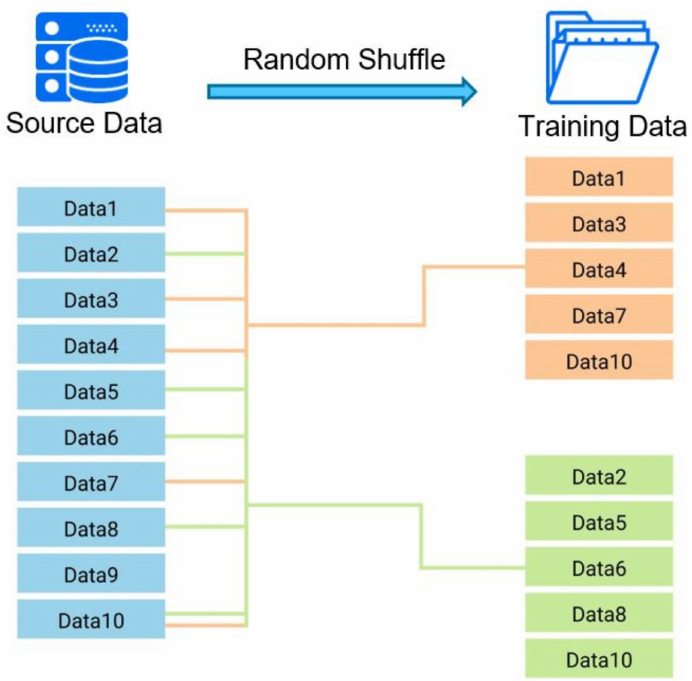
Figure 4. Schematic diagram of random shuffle.